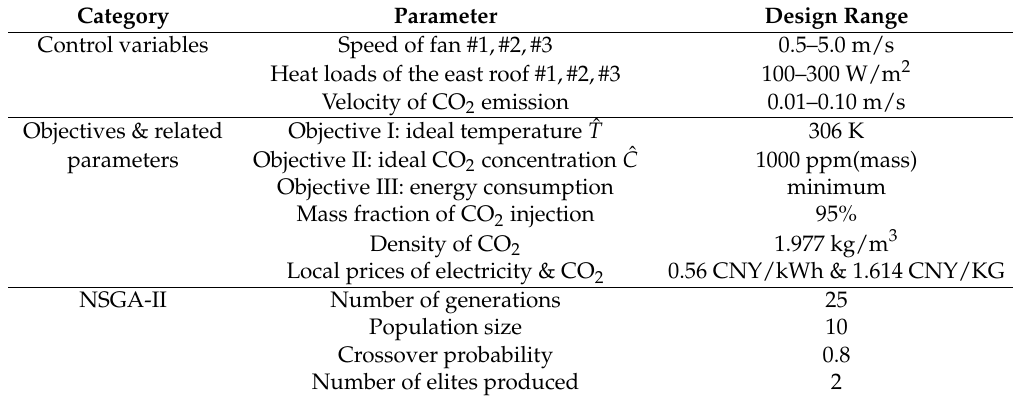
Table 2. Main parameters of the optimization case.